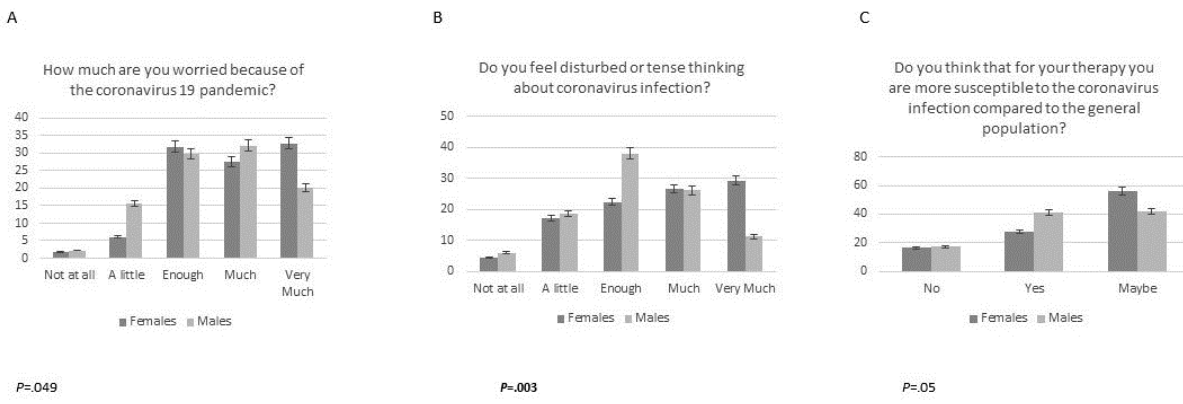
Figure 3. Comparison of COVID-19 survey results between male and female participants for Questions 1, 5, and 10